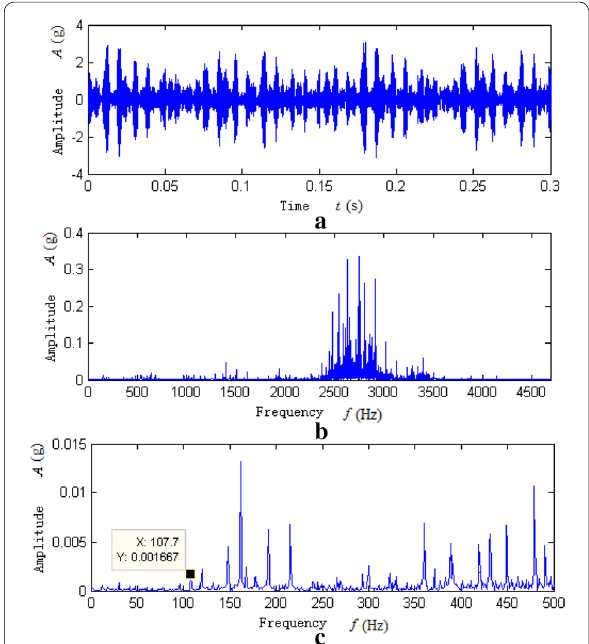
Figure 6 Inner race fault signal of 6205: ( a ) time waveform, ( b ) FFT spectrum, ( c ) local